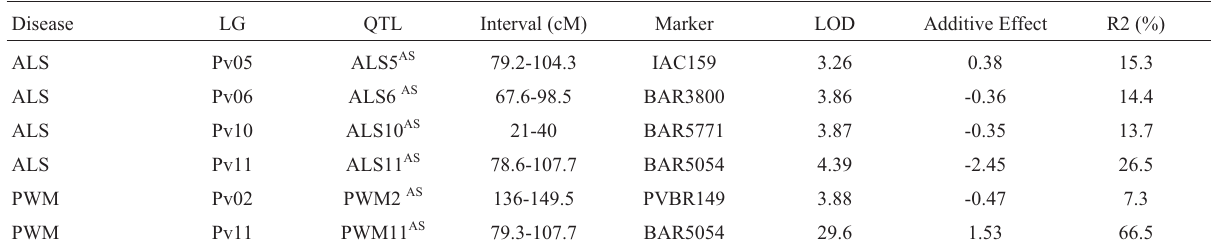
Table 3 - QTLs to angular leaf spot and powdery mildew resistance mapped in the AND 277 x SEA5 RIL common bean population using 80 SSRs and 251 SNPs.